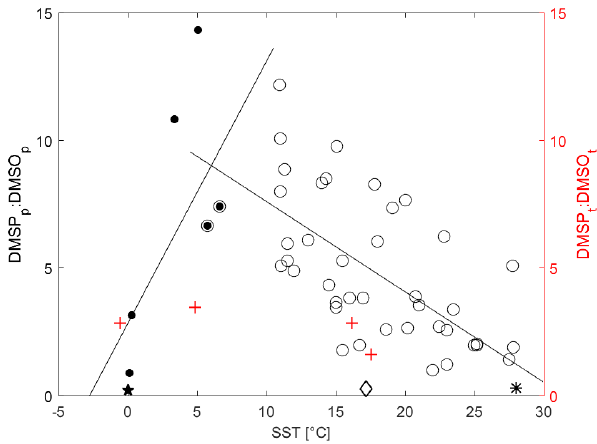
Figure 7. Average DMSPt:DMSOt vs. SST (red) and average DMSPp:DMSOp vs. SST (black). Mean ratios for individual campaigns are recalculated from the data listed in Simó and Vila-Costa (2006). We added data points consisting of the mean DMSPp:DMSOp and SST (given in parenthesis) from the East China Sea (0.27, 17.2 ◦ C, open diamond) (Yang and Yang, 2011), the northern Baffin Bay (0.20, estimated 0 ◦ C; closed pentagram) (Bouillon et al., 2002), and the western Pacific Ocean (0.22, 28 ◦ C, asterisk) (Zindler et al., 2013). The linear correlations are y = − 0 . 35 x + 11 . 13 ( R 2 = 0.45, open circles) and y = 1 . 03 x + 2 . 82 ( R 2 = 0.57, solid circles). Our Southern Ocean, ACC, and subtrop- ical open-ocean and coastal areas are the red plus